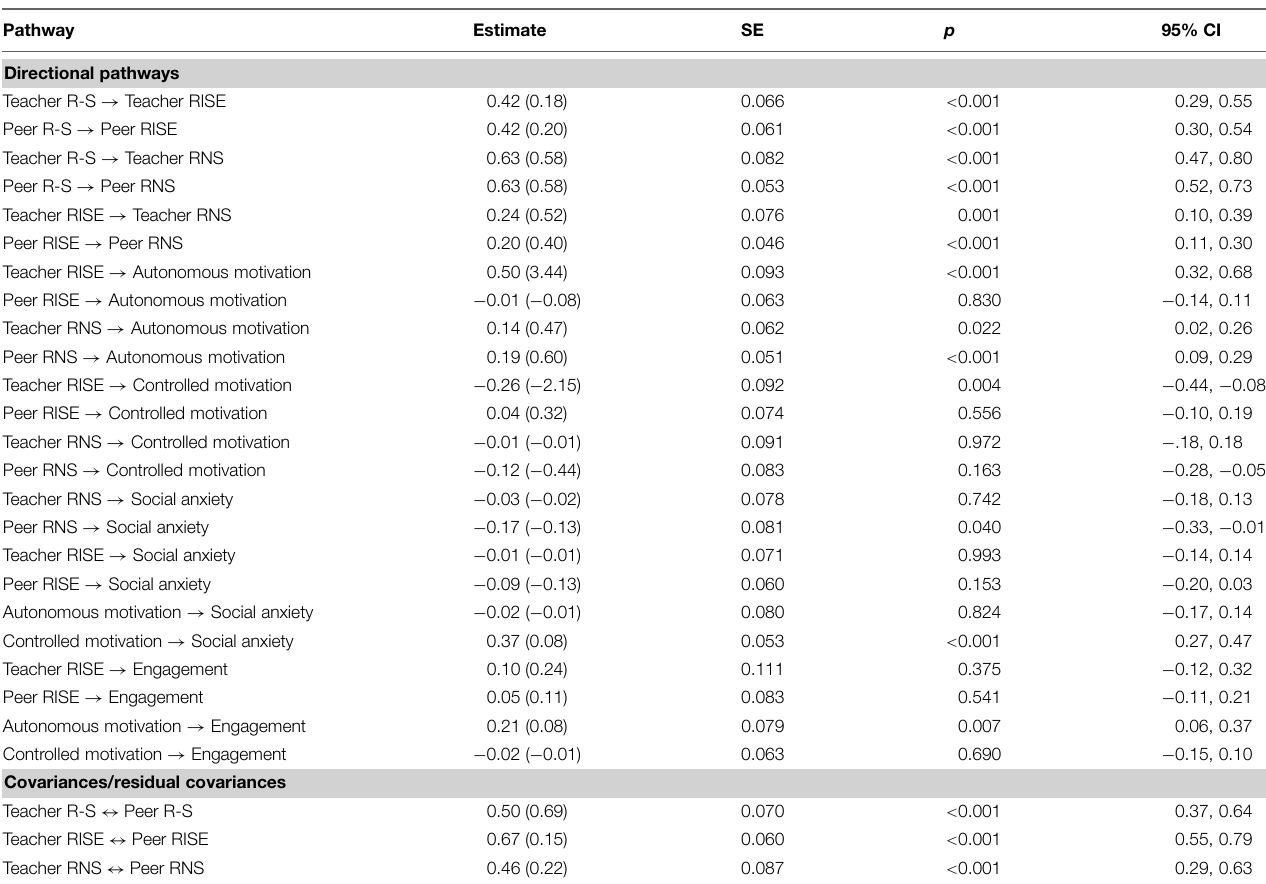
TABLE 2 | Standardized output for all structural pathways (unstandardized estimate in parentheses).